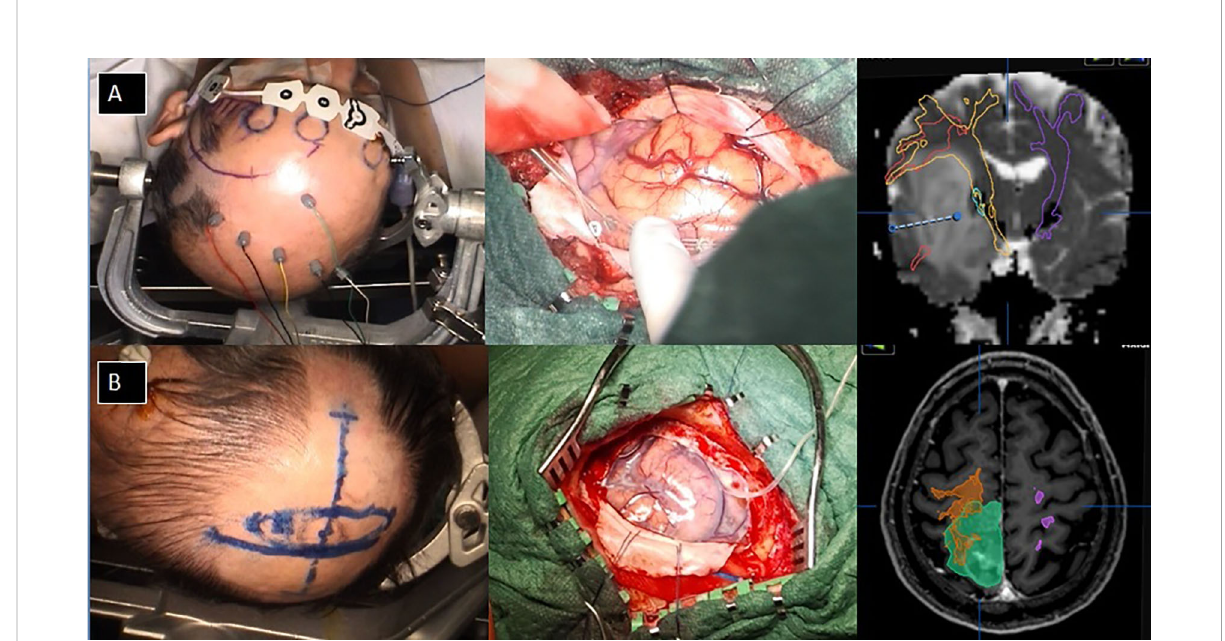
FIGURE 1 Examples of small craniotomy tailored on DTI and tumor projection to the cortex. (A) a case of an insula tumor with the intraoperative view and the neuronavigational planning; (B) a case of a parietal tumor with the intraoperative view and the surgical